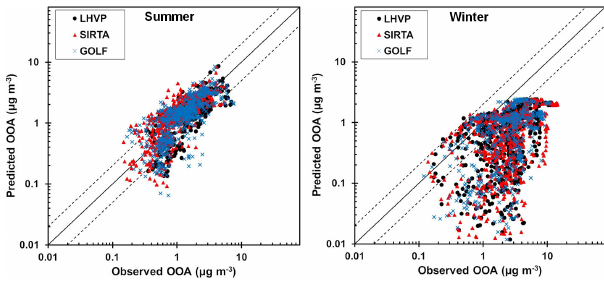
Figure 4. Comparison of predicted vs. observed PM 1 OOA (µgm − 3 ) from the three measurement stations during the MEGAPOLI summer and winter campaigns. Each point is an hourly average value. Also shown are the 1:1, 2:1 and 1:2 lines. Observed data represent AMS factor-analysis